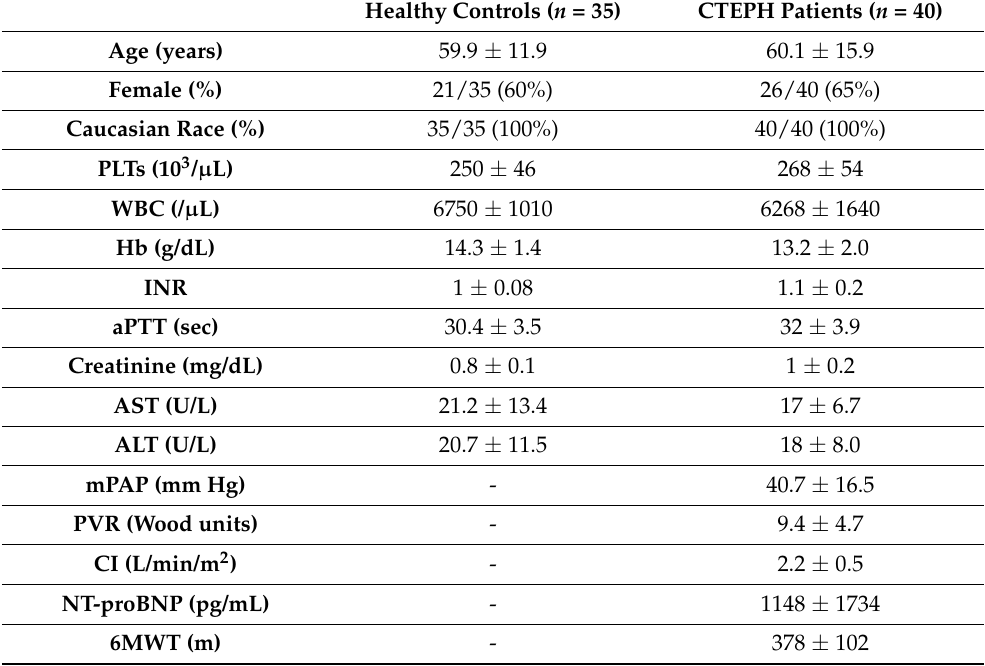
Table 2. Demographics and standard hematological tests of study participants. Hemodynamic measurements and clinical findings of the CTEPH